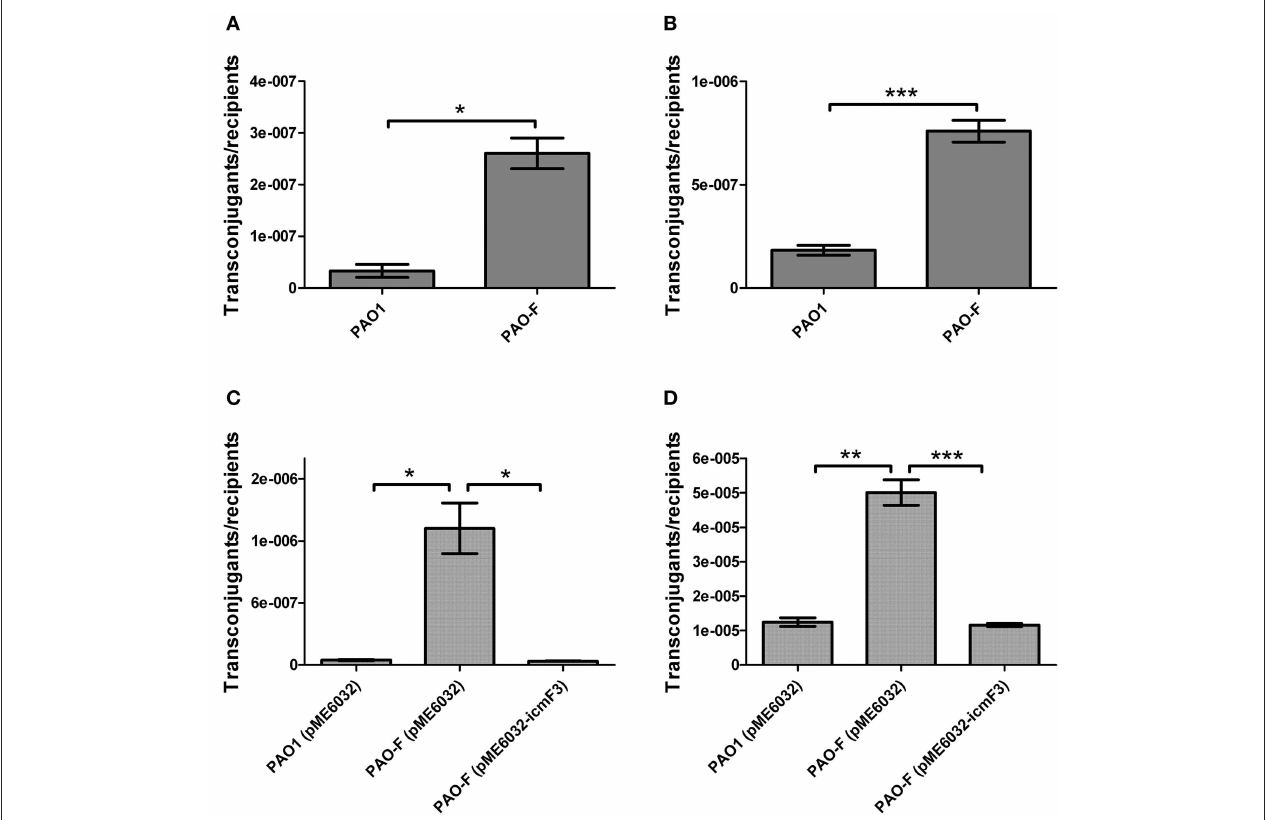
FIGURE 6 | Conjugation frequencies of wild type PAO1 and icmF3 mutant as recipients. (A,B) Recipient strains: wild type PAO1 and icmF3 mutant PAO-F; donor strain: E. coli S17-1 with pMP220. Donor and recipient strains were mixed in 1:1 ratio for (A) and in 10:1 ratio for (B) . (C,D) Recipient strains: PAO1 (pME6032), PAO-F (pME6032), PAO-F (pME6032- icmF3 ); donor strain: E. coli S17-1 with pBBR1MCS-5. Donor and recipient strains were mixed in 1:1 ratio for (C) and in 10:1 ratio for (D) . If needed, 1mM IPTG was included in the medium for induction. Data are presented as mean ± SD of a minimum of three independent experiments. * P < 0.05 , ** P < 0.01 , *** P < 0.001